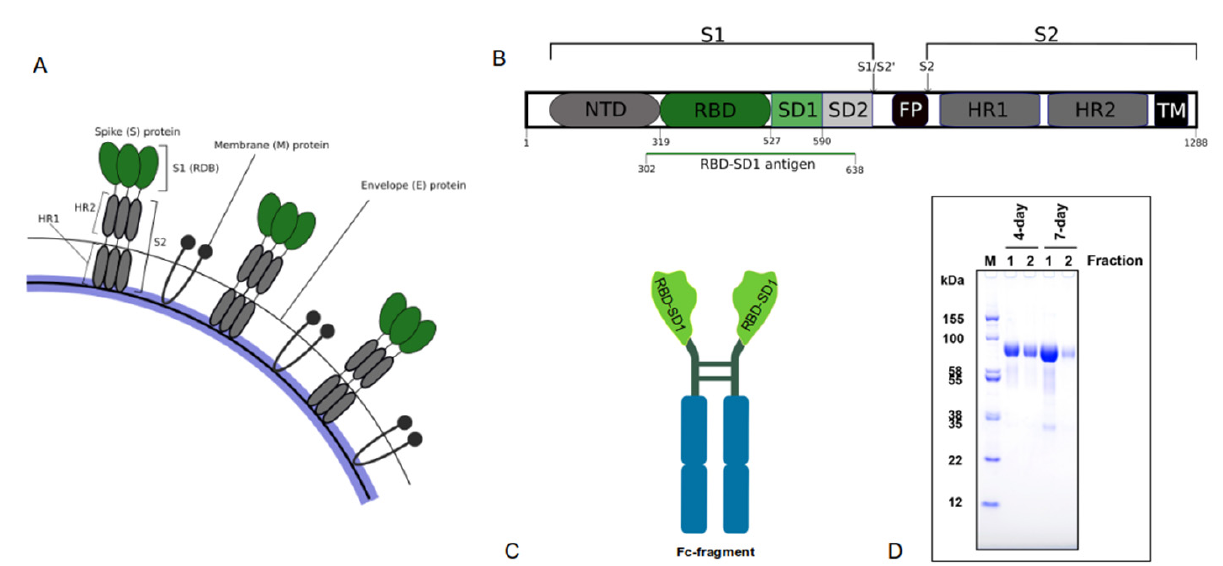
Figure 1. RBD-SD1-Fc antigen construction. ( A ) Schematic structure of SARS-CoV-2 envelope; ( B ) Graphical representation of the human S protein with signal peptide (SP), N-terminal domain (NTD), receptor-binding domain (RBD), SD1 and SD2 subdomains, fusion peptide (FP), heptad repeat 1/2 (HR1/2), and the transmembrane domain (TM). The cleavage sites are indicated by arrows. Adapted from [15]. Sequence cloned for antigen construction is indicated by green line; ( C ) Construction of Betuvax-CoV-2 antigen; ( D ) SDS-PAGE analysis of purified RBD-SD1-Fc protein (M—marker), 10 µg load.